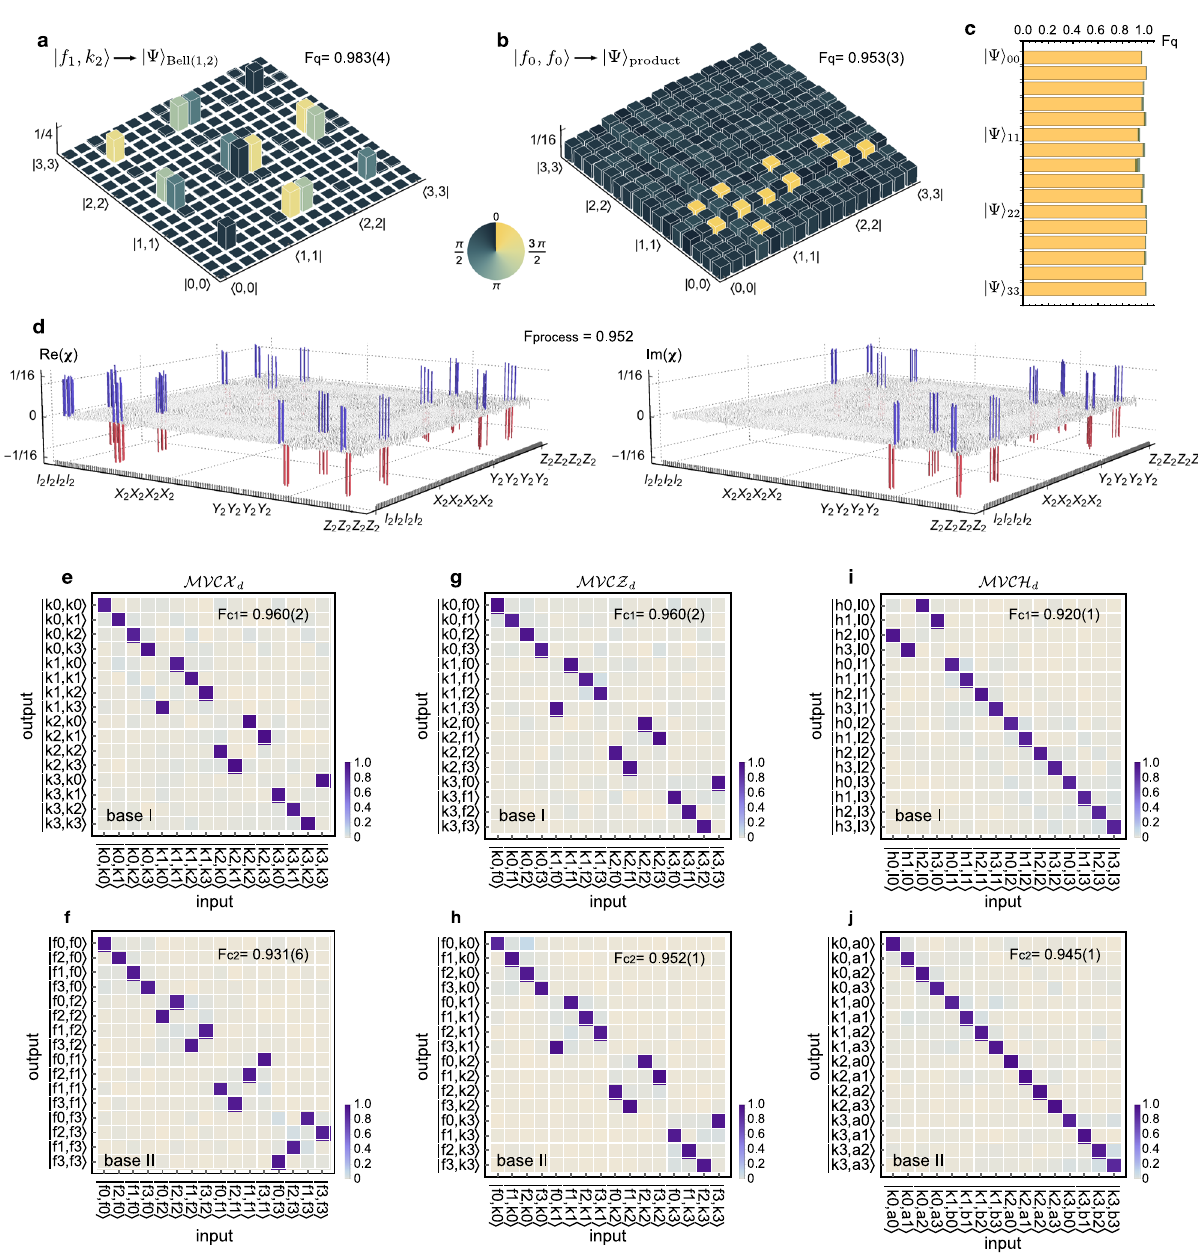
Fig. 3 Characterisation of quaternary multi-value controlled-unitary logic operations. a , b Measured density matrices ( ρ ) for a four-level maximally entangled Bell state and a fully product state. Column heights (colours) represent absolute values ∣ ρ ∣ (phases Arg( ρ )) of the elements. Quantum state fi delity F q was measured to be 0.983(4) and 0.953(3), respectively. c , Measured quantum state fi delities for a complete set of four-level Bell states Ψ j i (cid:1) (cid:1) (cid:3) (cid:3) i ; j , (cid:1) (cid:1) i , j = 0,1,2,3. The generalised Bell states are created by operating input states of f (cid:3) k j in the MVCX d gate. Shaded areas atop bars refer to ± 1 σ error i bars. The F q values in a – c were estimated by Monte Carlo the photon counts with photon Poissonian statistics. d Reconstructed process matrix ( χ ) of the MVCX d gate. It was measured by quantum process tomography with in total 256 quantum state tomographic measurements. We obtained the quantum process fi delity of 0.952, that is de fi ned as Tr[ χ 0 χ ], where χ 0 is the ideal matrix. The χ matrix is represented in the standard identity and Pauli basis { I 2 , X Y Z – j Measured truth tables (normalised photon counts) for three MVCU logic gates in two 2 , 2 , 2 }. Blue and red colours are used to improve the clarity. e complementary bases {I, II}: e , f , a multi-value controlled- X d (MVCX d ) gate; g , h , a multi-value controlled- Z d (MVCZ d ) gate; i , j , a multi-value controlled- (cid:1) (cid:1) (cid:1) (cid:1) (cid:3) (cid:3) (cid:3) (cid:3) (cid:1) (cid:1) (cid:1) (cid:1) H fi nitions of basis are given as: computational basis k ; Fourier basis f i ; Hadamard basis h i ; basis l i is another eigenstate of (cid:1) (cid:1) d (MVCH d ) gate. The de (cid:3) (cid:3) i (cid:1) (cid:1) the Hadamard and a i and b i are given by rotations, which are provided in Supplementary ( i = {0, 1, 2, 3}). Classical statistic fi delities ( F c 1 , F c 2 ) are measured, which are adopted to estimate the lower and upper bound of the complementary classical fi delity: [0.891(2), 0.931(1)] for the MVCX d , [0.912(2), 0.952(1)] for the MVCZ d , and [0.865(1), 0.920(1)] for the MVCH d . In e – j , the probability distributions are colour coded (key is provided at the right bottom). The values in parentheses of F c and F q refer to ± 1 σ uncertainty from photon statistics.